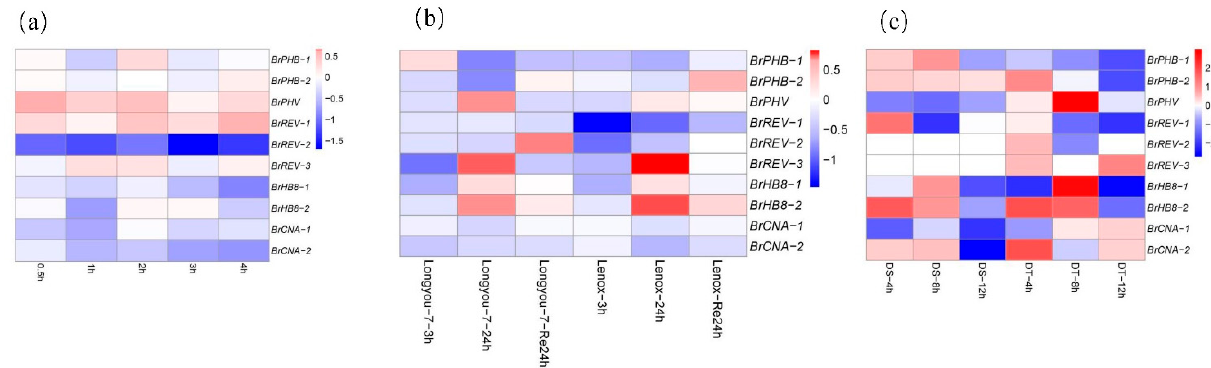
Figure 6. Expression profiling of HD-ZIP III genes under abiotic stresses in B. rapa . ( a ) Differential expression profiling of HD-ZIP III genes under 45 °C heat stress for 0.5, 1, 2, 3 and 4 h in Chinese cabbage. ( b ) Differential expression profiling of HD-ZIP III genes under low-temperature stress at 4 °C for 3 h, 24 h and recovery at 22 °C for 24 h in a cold-tolerant cultivar (Longyou-7) and a cold-sensitive cultivar (Lenox). ( c ) Differential expression profiling of HD-ZIP III genes after a drought treatment for 4, 8 and 12 h in drought-sensitive (DS) and drought-tolerant (DT) genotypes. The heatmaps were built using log2-based fold change values of the treatment/control.